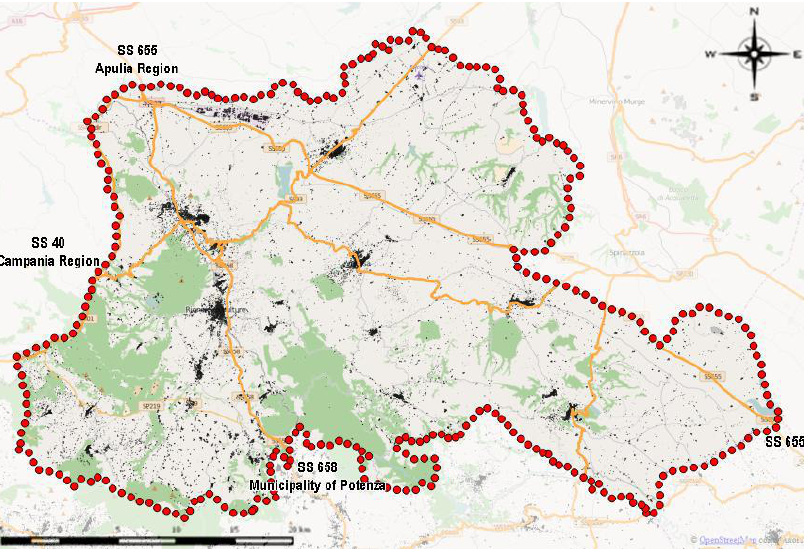
Figure 10. Infrastructures in the study area and urban areas/artificial lands in 2010.